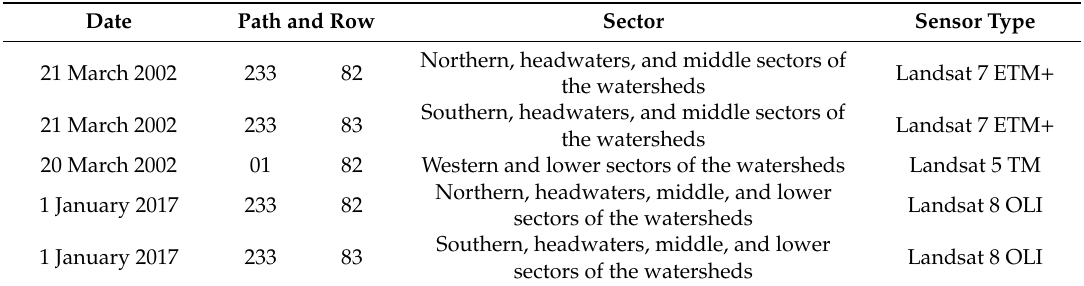
Table 1. Description of images for